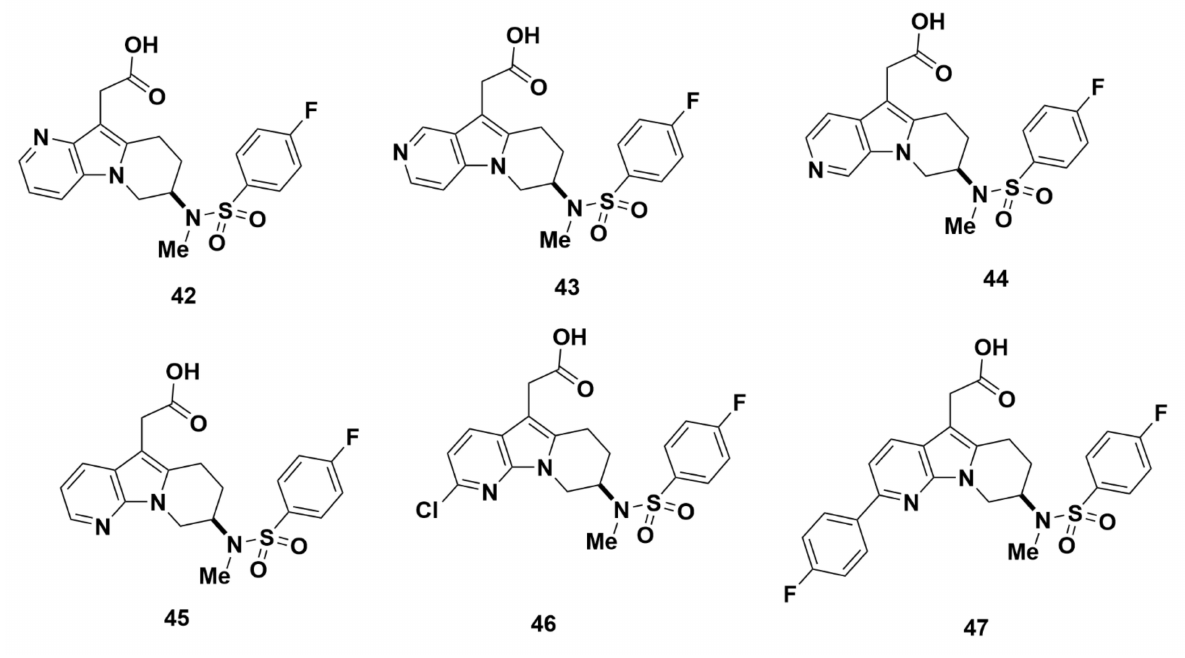
Figure 11. Molecular structures of compounds 42 – 47 .